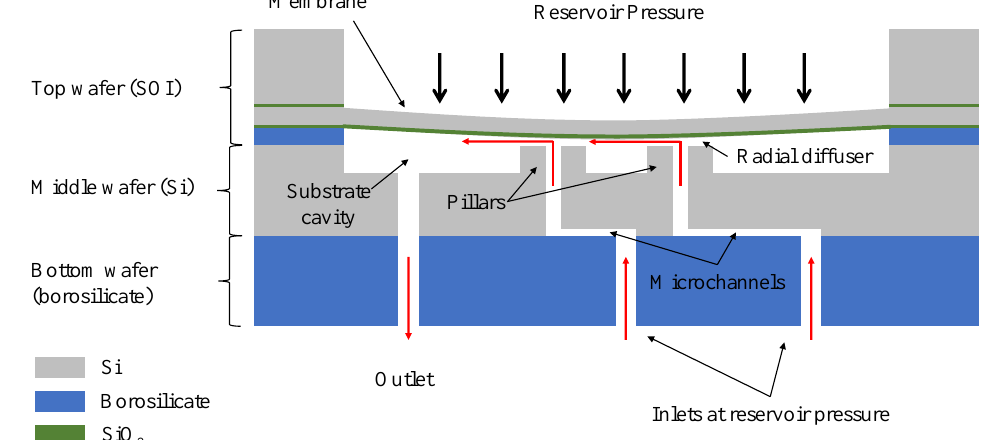
Figure 6. Schematic cross-section of a triple-stack microfluidic device dedicated to drug delivery at a constant flow rate of less than 10 mL/h, with a top SOI wafer (membrane), an intermediate borosilicate layer, a middle Si wafer (substrate) comprising pillars, through holes and microchannels, and a bottom borosilicate wafer with inlet and outlet ports. The top surface of the membrane and the inlet ports are in direct communication with the pressurized reservoir. The direction of the flow is indicated by red arrows. As the pressure increases, the gap between the membrane and the pillars (i.e., the radial di ff users) narrows and the hydraulic resistance of the device increases to keep the flow rate constant (adapted from Reference